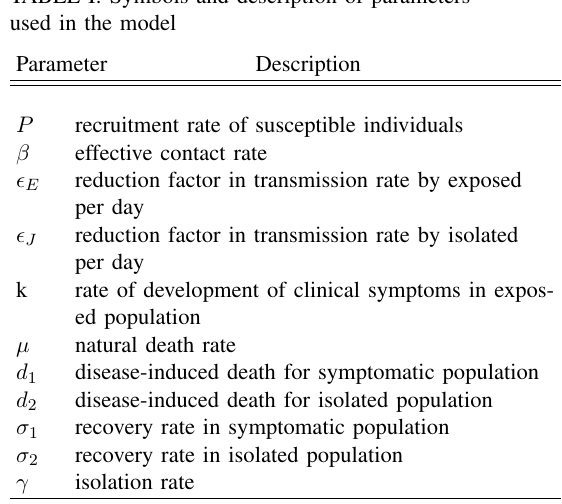
TABLE I: Symbols and description of